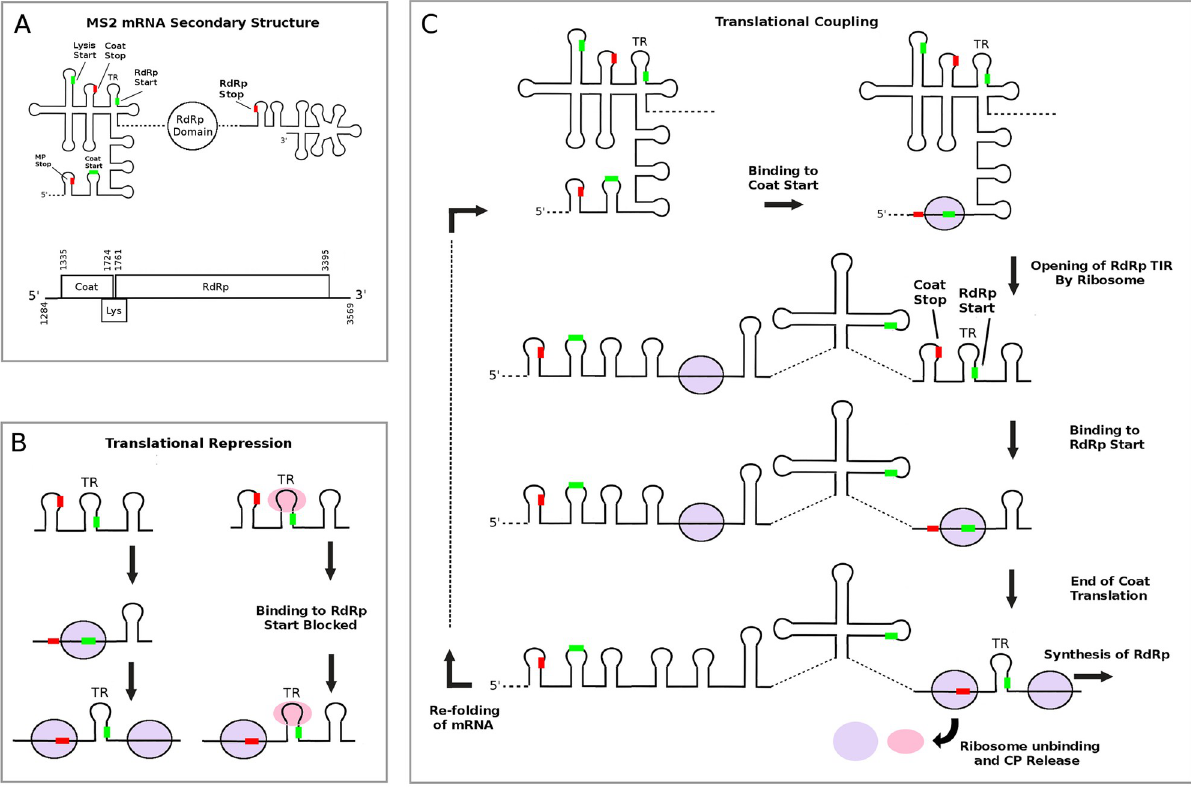
Fig 4. The translational coupling and repression mechanisms in bacteriophage MS2 mRNA. (A) Secondary structure cartoon of the bacteriophage MS2 coat and RdRp genes determined by phylogenetic analysis and enzymatic probing. (B) Translational repression of the RdRp gene occurs after synthesis of sufficient coat protein, which then binds to the translational repression (TR) hairpin that contains the start codon for the RdRp gene, blocking further ribosome initiations at this gene. (C) Diagram showing the translational coupling between the coat protein and RdRP genes. Synthesis of coat gene by the ribosome opens up a secondary TIR for the RdRp gene after melting of mRNA structure, allowing ribosome initiation at the RdRp start codon. Re-folding of the mRNA after translation of the coat gene hides the TIR for the RdRp gene.